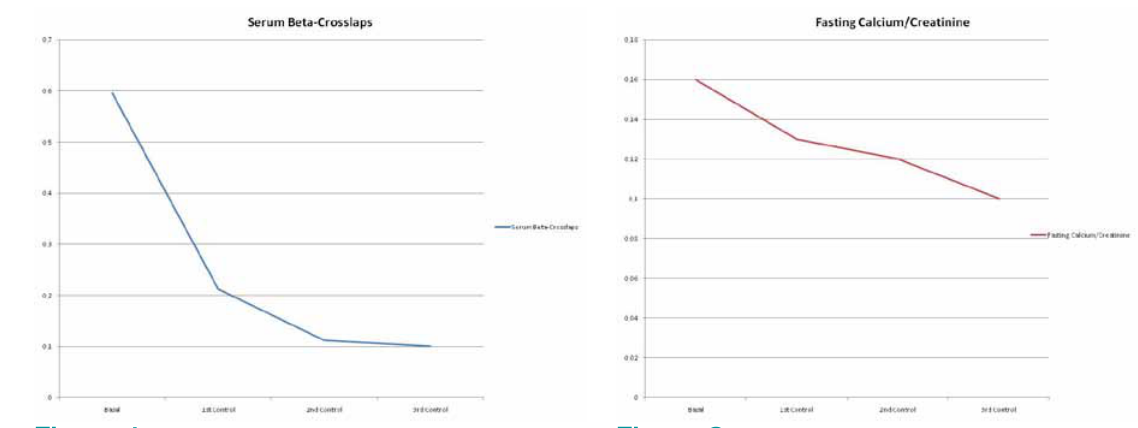
Figure 1. Evolution of plasma levels of beta-crosslaps after 3 years of treatment with alendronate